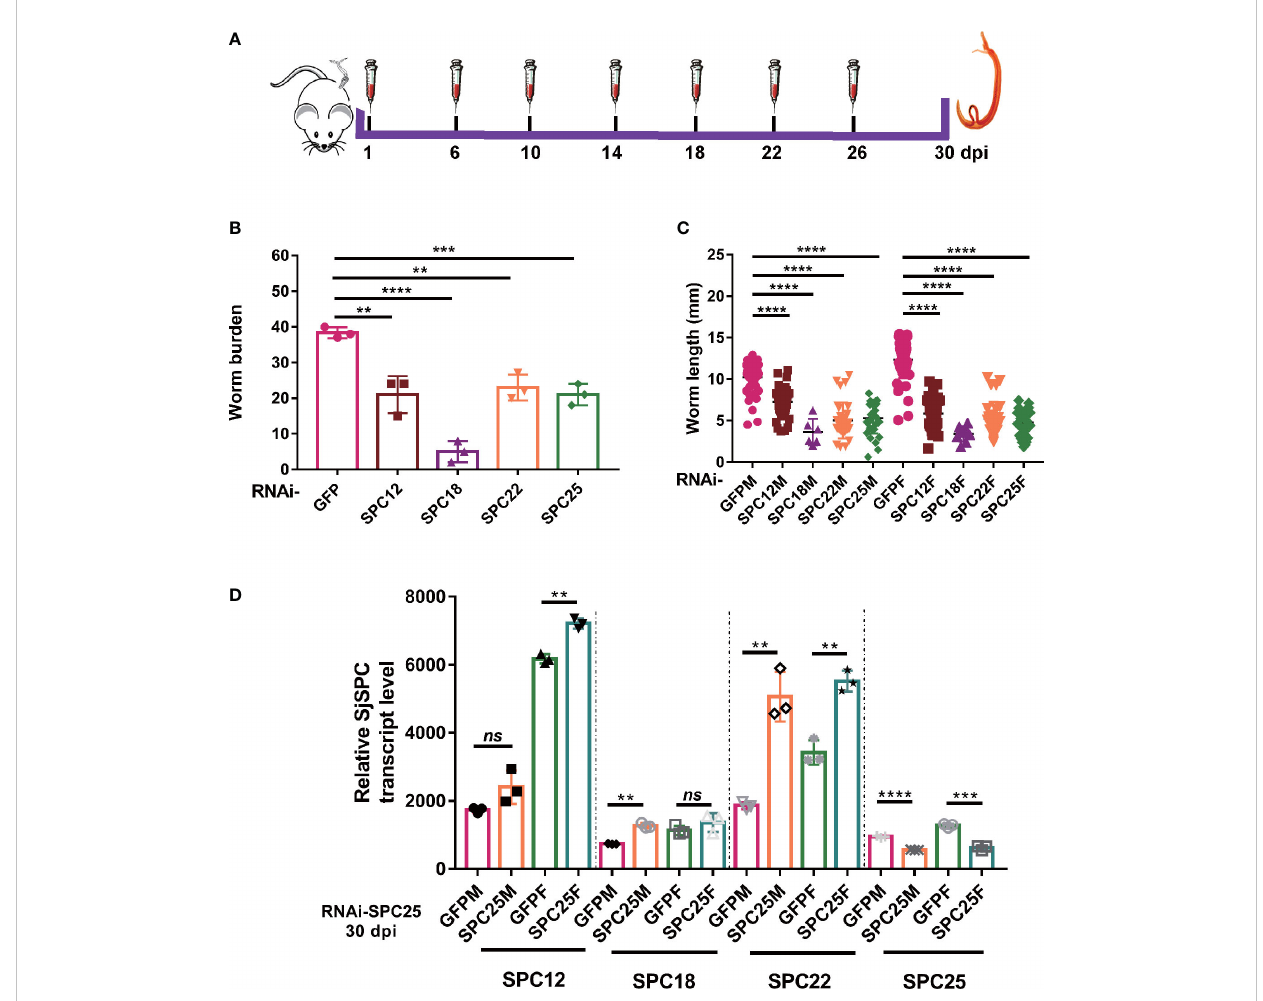
FIGURE 1 Suppressing the expression of SPC elements dramatical impairing the development and leading to the death of schistosomula. (A) Schematic diagram of the gene interference process of schistosomula in vivo . (B) Assessment of worm burden of dsRNA-mediated RNA effects. (C) Evaluation of worm length recovered from mice at 30 dpi. And worm length data were obtained from all worms recovered in three mice. (D) The expression level of SPC25 and other components of SPC in the RNAi-SPC25 worms. Each group had three biological replicates (three mice), and the data were shown as means ± SEM. ** p < 0.01, *** p < 0.001, **** p < 0.0001, ns, not signi fi cant,